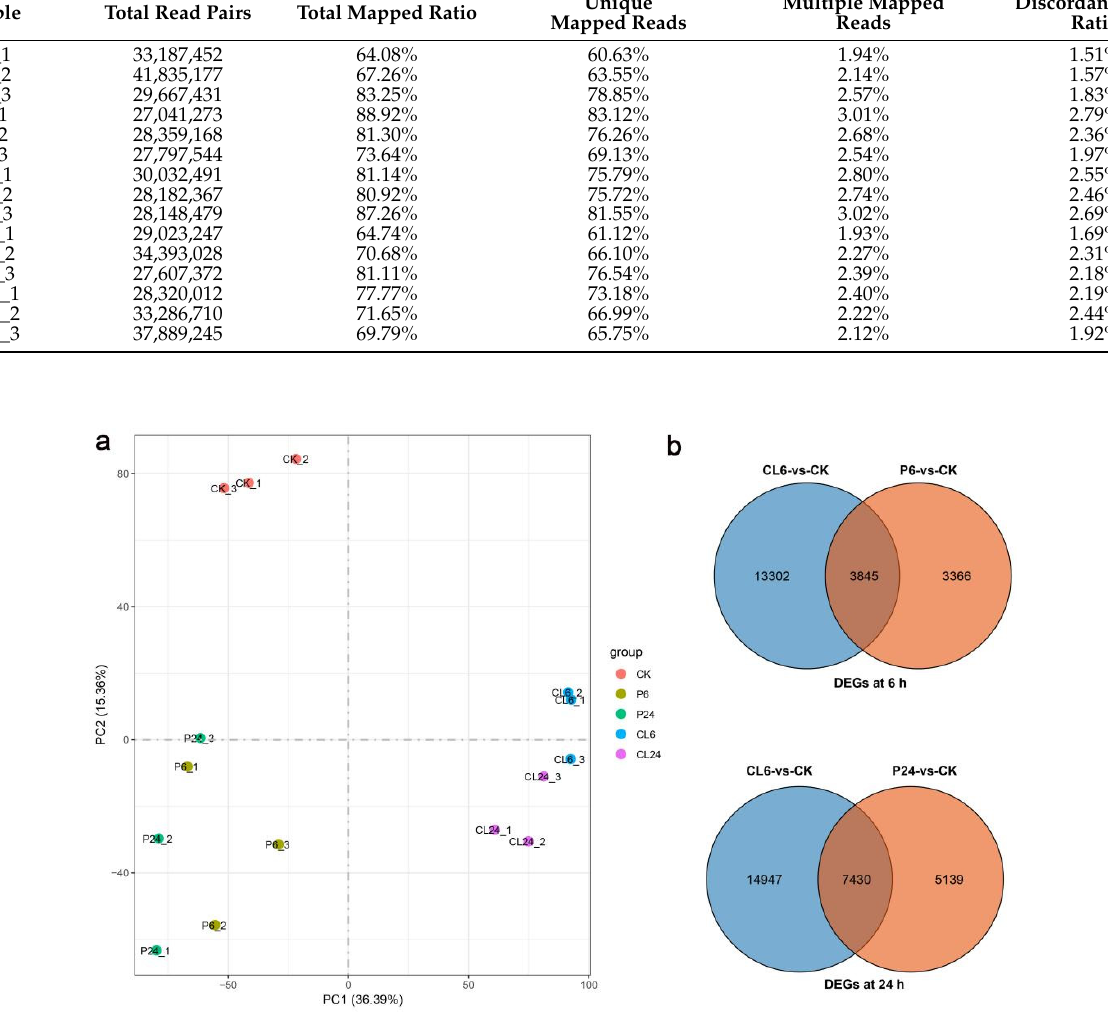
Figure 1. Comparative analysis of the transcriptome profiles of H. hamabo roots under salt (CL) and drought (P). ( a ) PCA of mRNA populations from CK, CL6, CL24, P6, and P24. ( b ) Venn diagrams showing overlap of regulated genes in response to the two abiotic stresses at 6 h and 24 h.